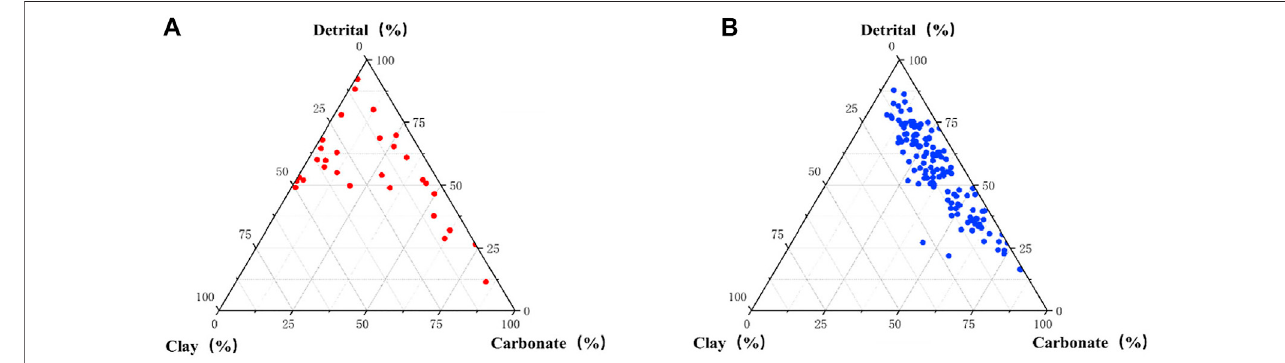
FIGURE 3 | Ternary diagrams of the mineral composition. (A) P 2 l 2 mineral composition and; (B) P 2 l 1 mineral composition.